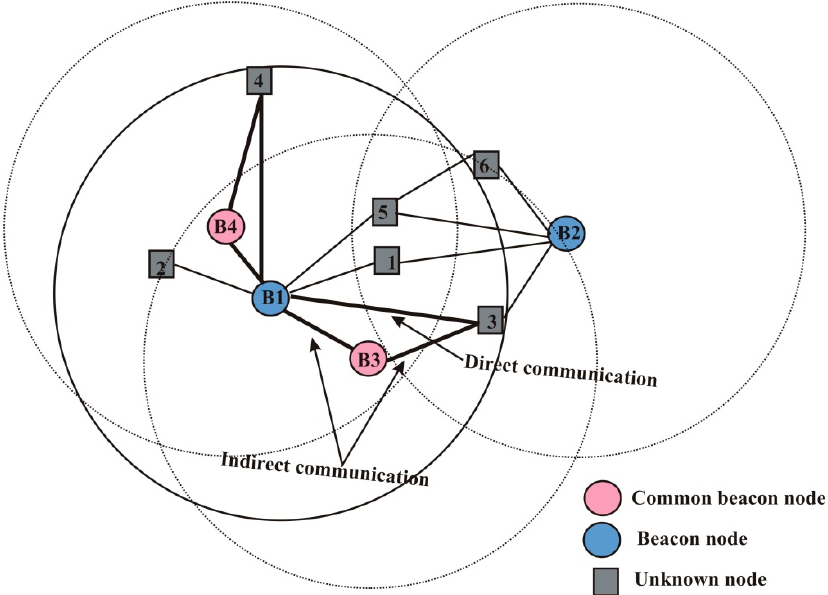
Figure 4. Unknown nodes with direct and indirect communication.